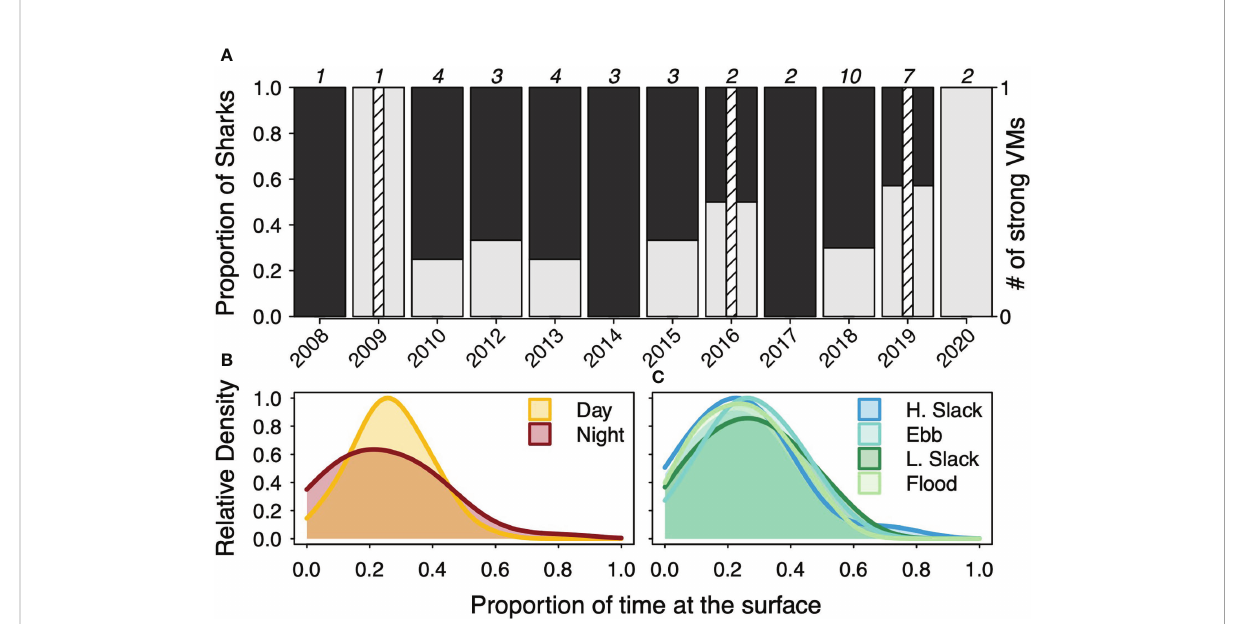
FIGURE 4 (A) The proportion of basking sharks in each tagging year that were classi fi ed as diel vertical migrators (DVM) or reverse DVM as well as the number of strong vertical migrators. The total number of tagged sharks in each year are noted at the top of each year. The relative density of proportion of time at the surface in the day or night diel periods (B) or high slack (H. slack), ebb, low slack (L. slack), or fl ood tidal periods (C) across all deployments.